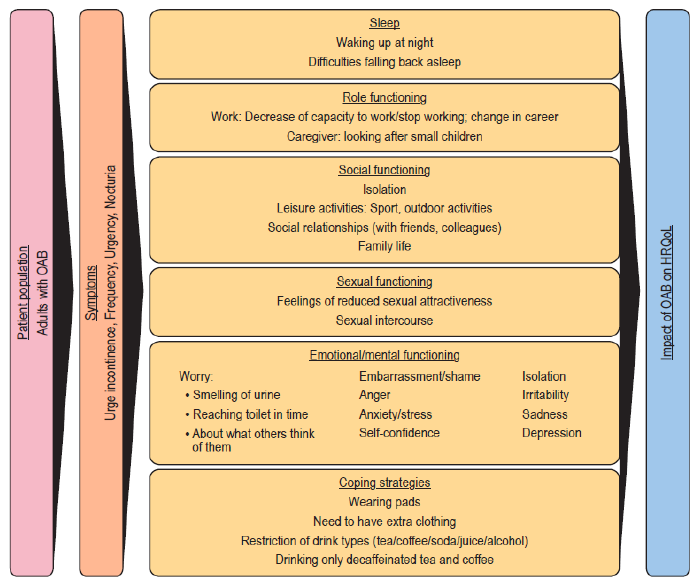
Figure 1. Conceptual Framework of Health-related Quality-of-life Concepts Associated with Overactive Bladder, Based on Patient